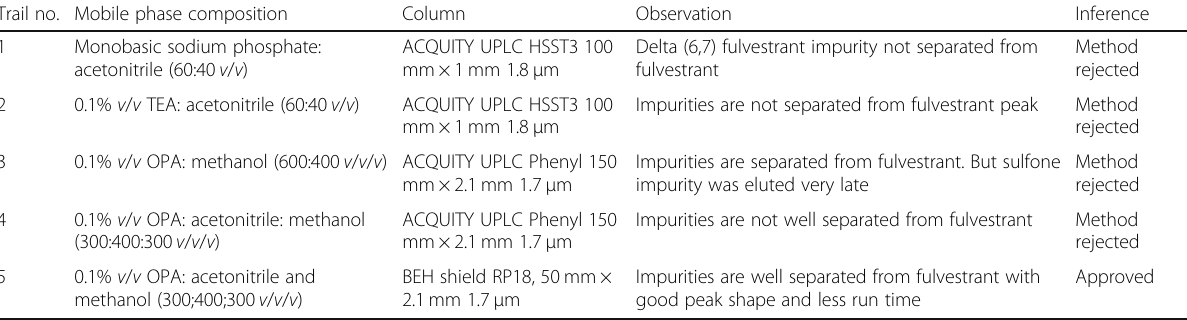
Table 1 Optimization mobile phase and column in method development Trail no. Mobile phase composition Column Observation Inference